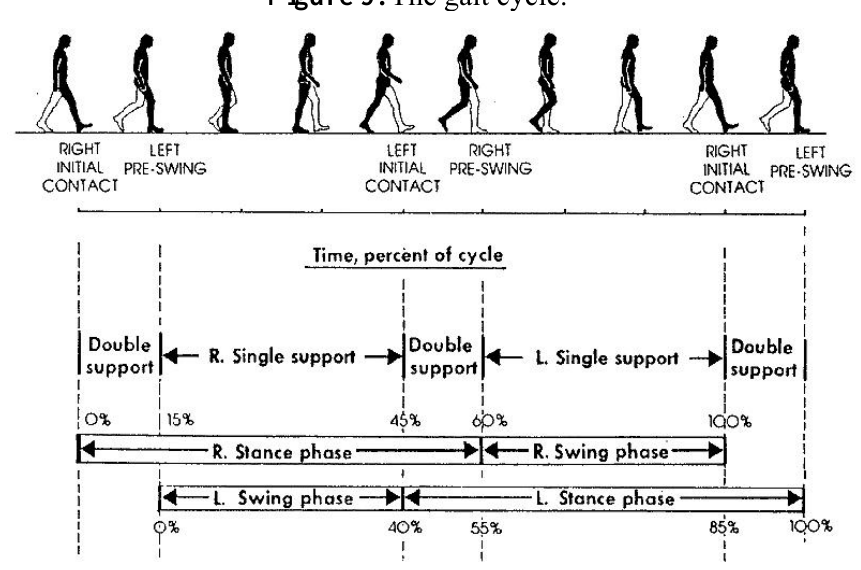
Figure 9. The gait cycle.